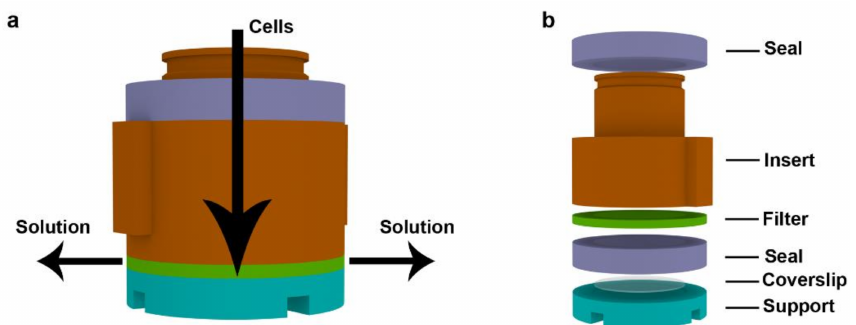
Figure 4. The schema of the flow of the filtered solution and the schema of the CytoTrap arrangement used for wet centrifugation. ( a ) The schema of the flow of the filtered solution through the filter (only the inner part of the device is depicted) during centrifugation is shown. The solution is collected in the 50 mL tube and the cells are captured on the surface of the coverslip. The arrows show the flow of the cells and solution during centrifugation. ( b ) The schema of the CytoTrap arrangement used for wet